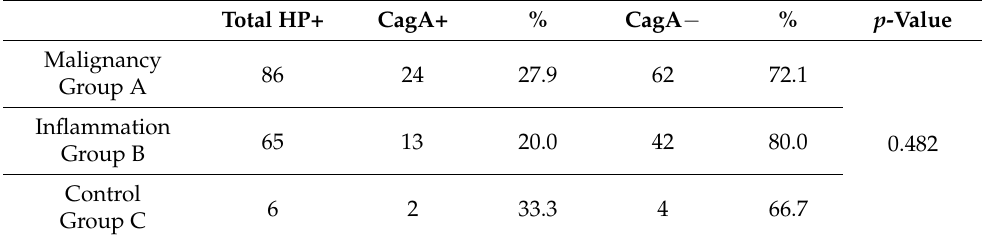
Table 3. Percentage of the CagA+ genotype in samples with Helicobacter pylori